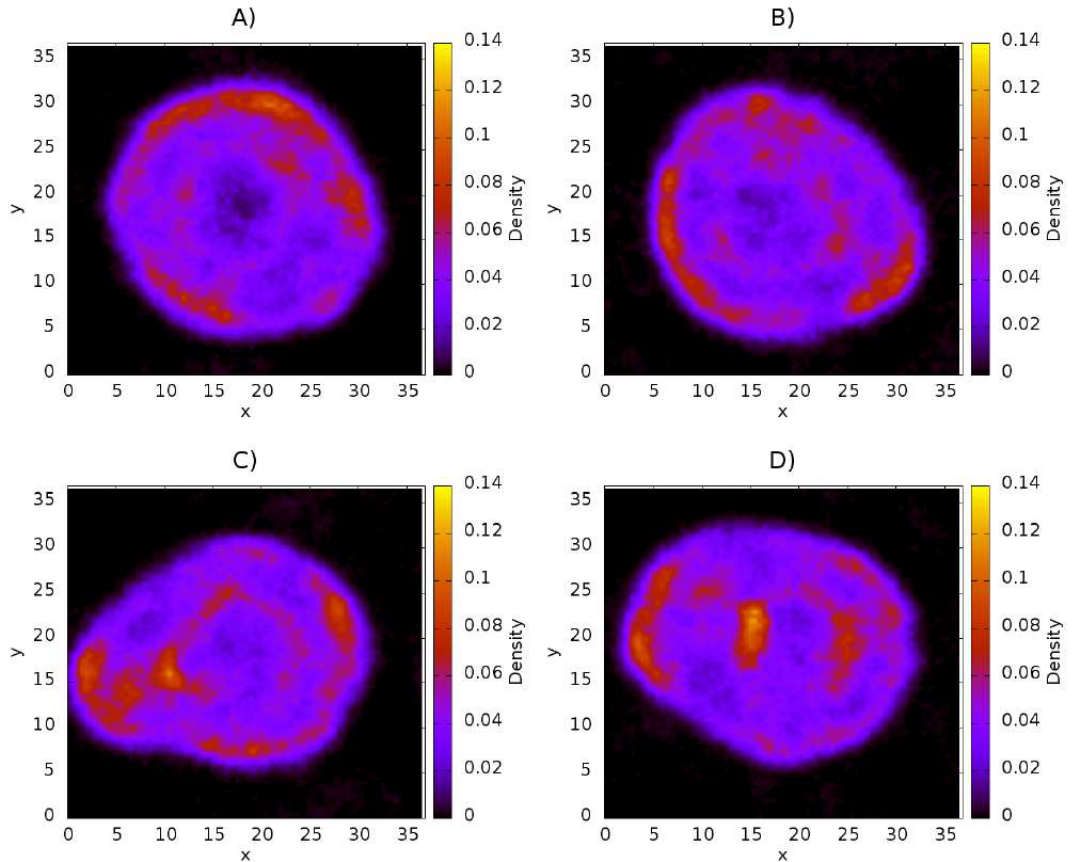
Figure 5. Influence of CS concentration on capsaicin on the xy plane at different concentrations of the CS polymer. ( A ) 50 chains of CS; ( B ) 100 chains of CS; ( C ) 150 chains of CS; ( D ) 200 chains of CS. All quantities are reported in reduced DPD units.